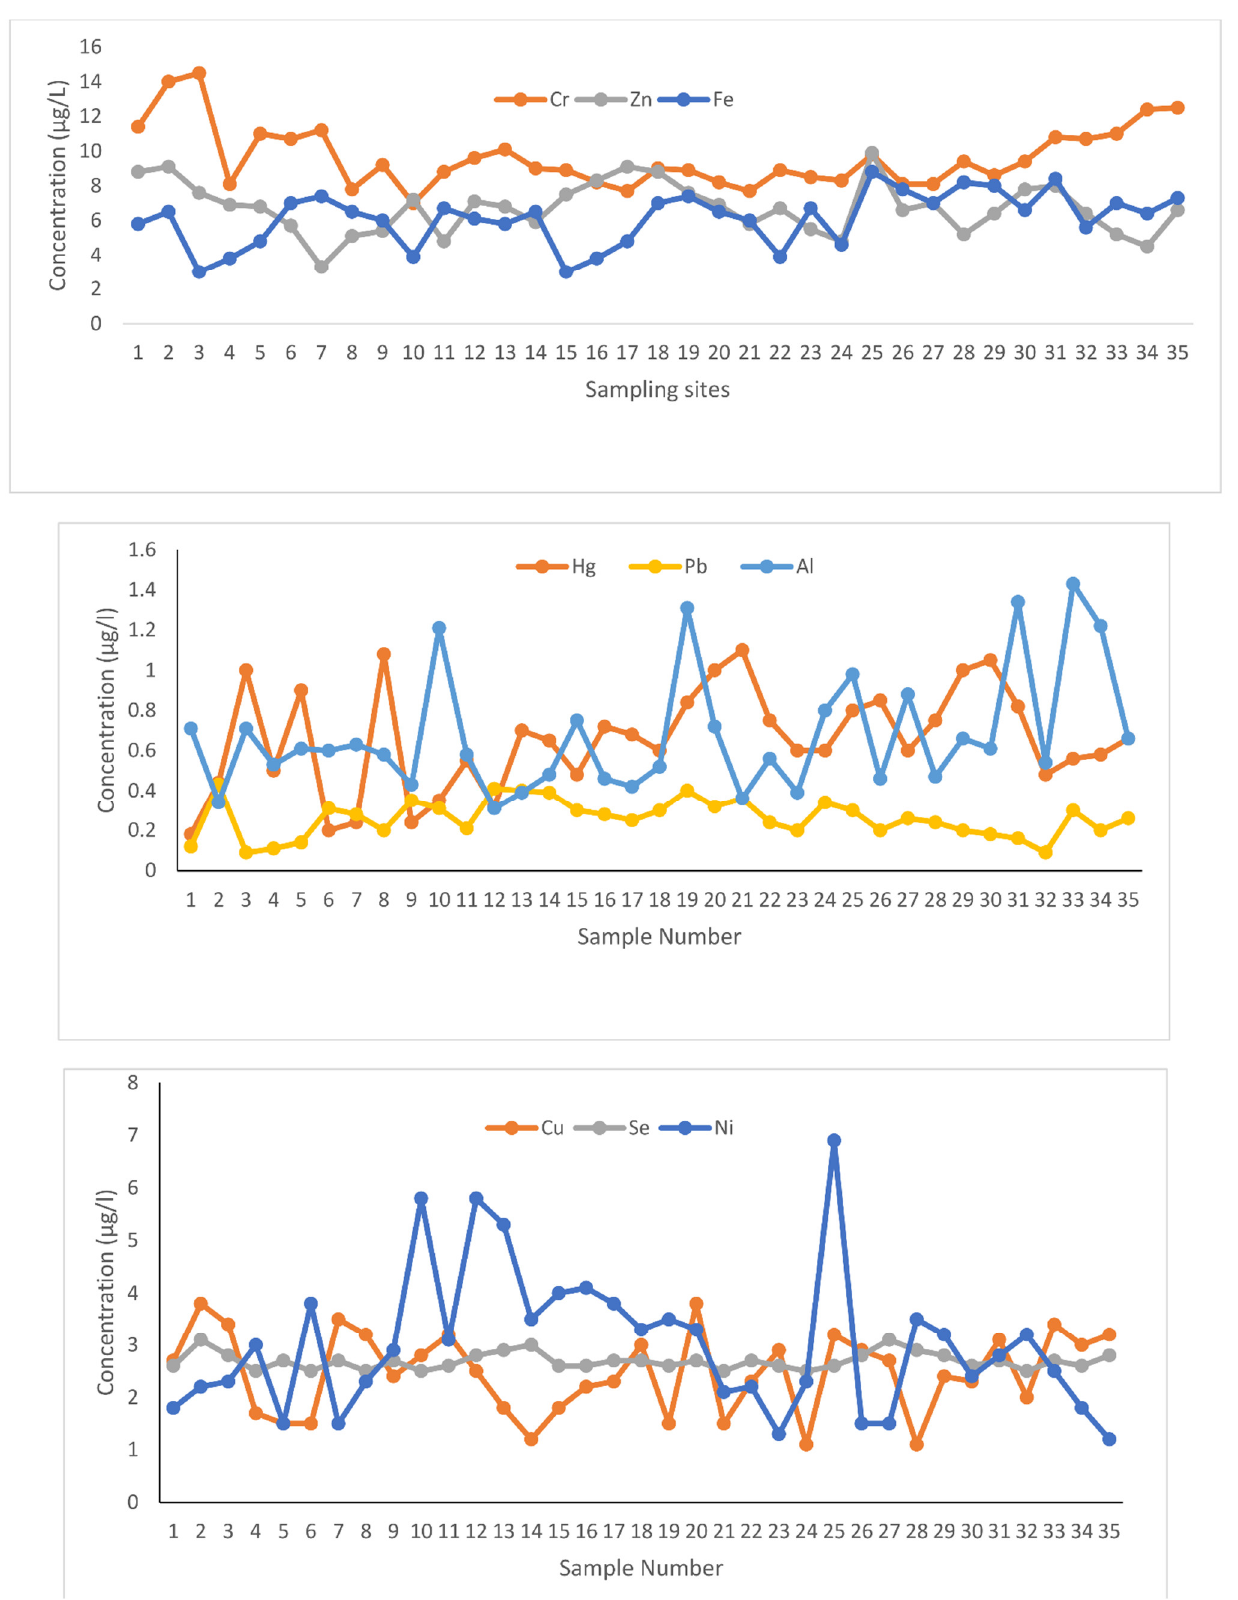
Figure 2. Distribution of Cr, Zn, Fe, Hg, Pb, Al; Cu, Se, and Ni in seawater samples.